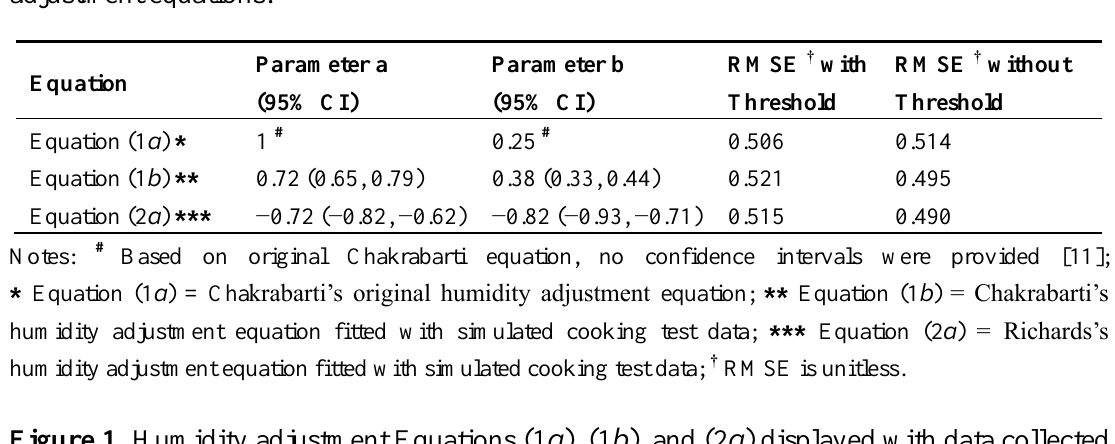
Table 1. Summary of regression parameters and RMSE for the three humidity adjustment equations.